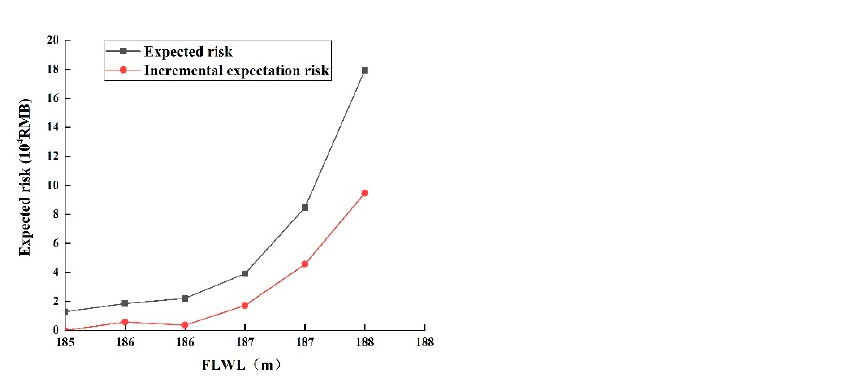
Figure 3. Probability of exceedance and increases in the post-flood season.